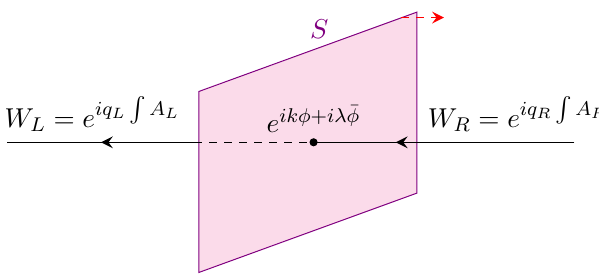
Figure 3 . Gauge-invariant configuration of Wilson lines and twist operators on a defect S in U(1) 2 N Chern-Simons